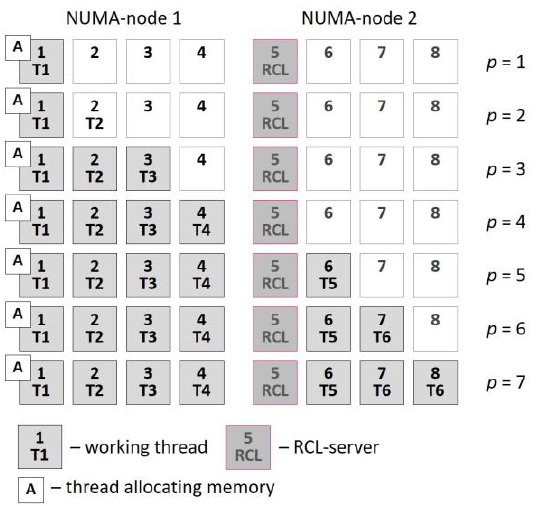
Figure 4. Thread affinity to the processor cores in the experiments, p = 2, …, 7.